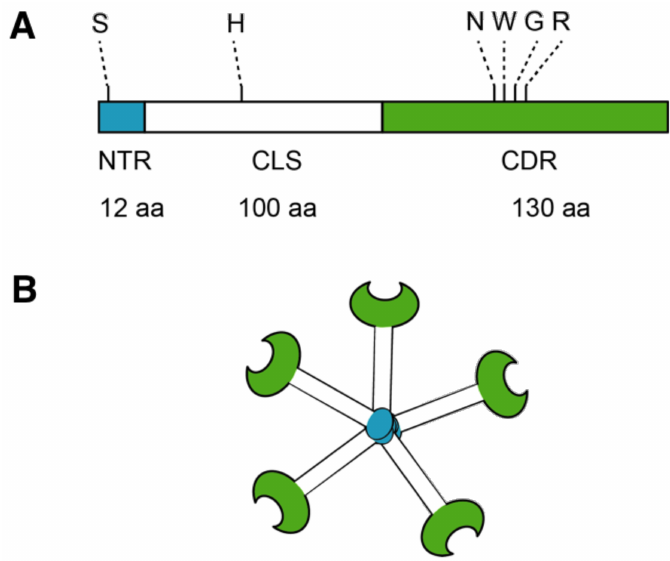
Figure 2. Structure of Galectin-3. ( A ) Galectin-3 protein structure consists of N terminal Domain (NTD), which has a N terminal Region of 12 amino acids (aa) and contains serine 6 (S) phosphorylation site. The carbohydrate recognition domain (CRD) 130 aa comprise the C-terminal and contains the NWGR motif; ( B ) Pentameric structure of